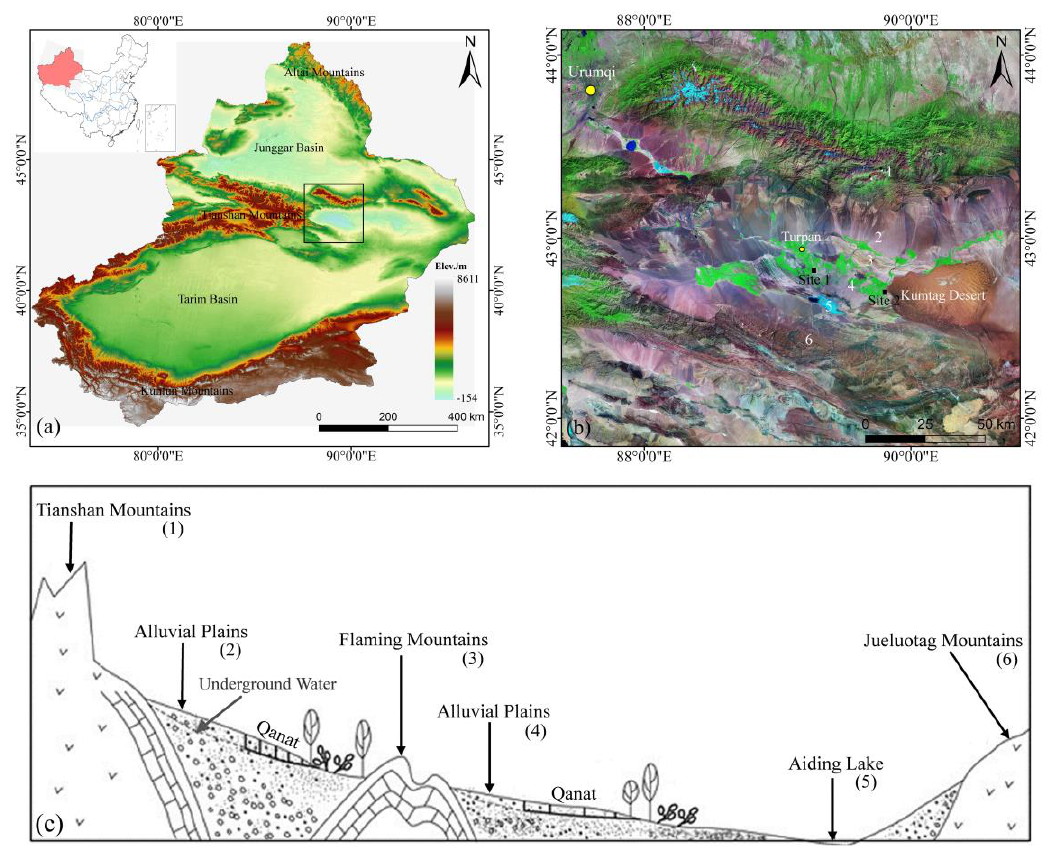
Figure 1. Location of the Turpan Basin in China. ( a ) DEM color shaded-relief map of Xinjiang. ( b ) Landsat5 TM 742-band false-color image of Turpan Basin, the white numbers corresponding to the black numbers in ( c ) Diagrammatic cross-section of Turpan